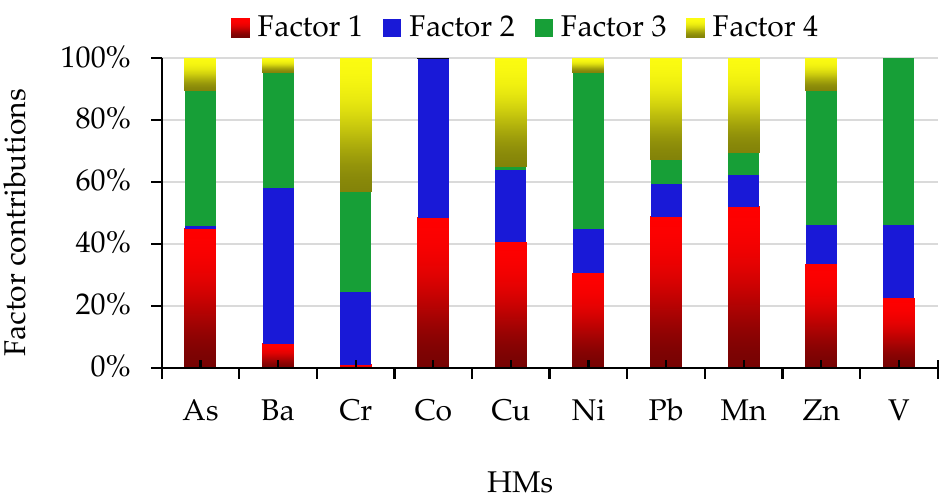
Figure 3. Source contribution rates of HMs in sediments of the Mianyang section of the Fujiang River.